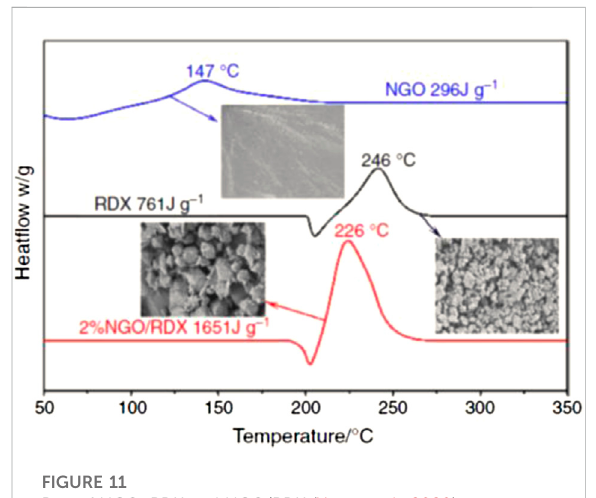
FIGURE 11 Dsc of NGO, RDX and NGO/RDX (Yuan et al., 2020).